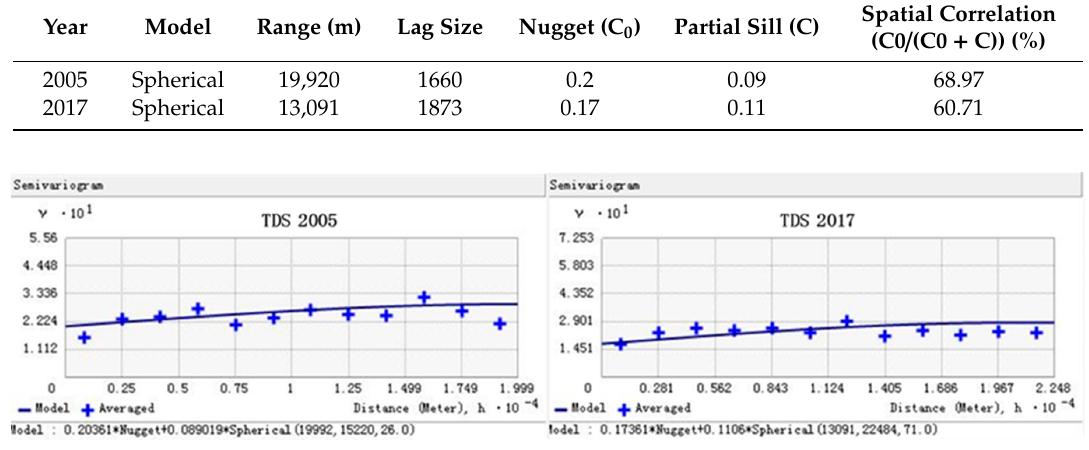
Table 1. Key parameters and their variability for the semi-variogram fitting of TDS.